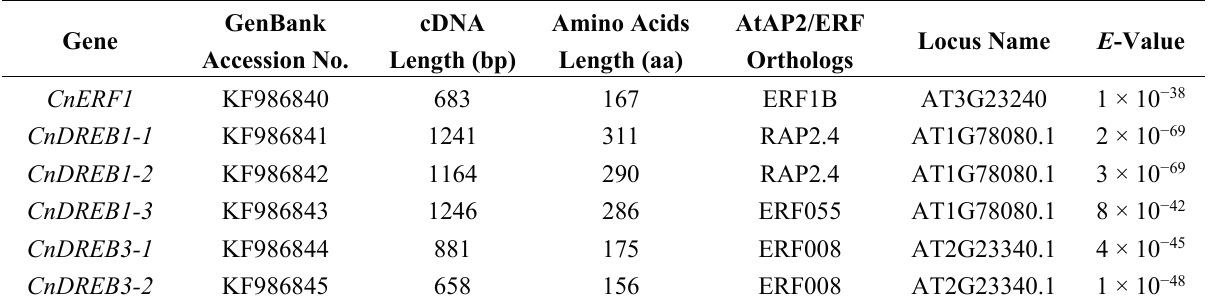
Table 1. CnAP2/ERF TF sequences and the identity of likely A. thaliana homologs. GenBank Gene Accession